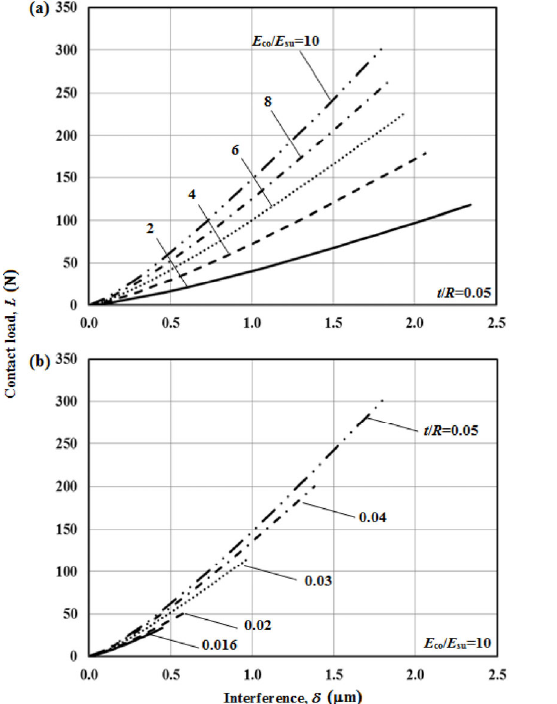
Fig. 11 Typical results for the contact load L vs. the interference